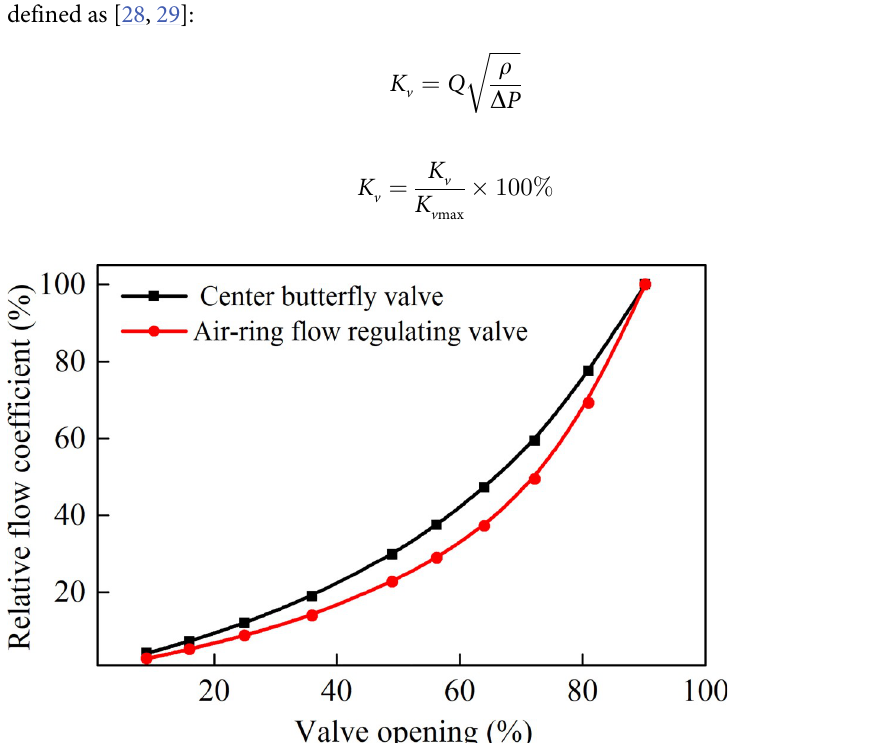
Fig 9. Relative flow coefficient of both valves at different valve